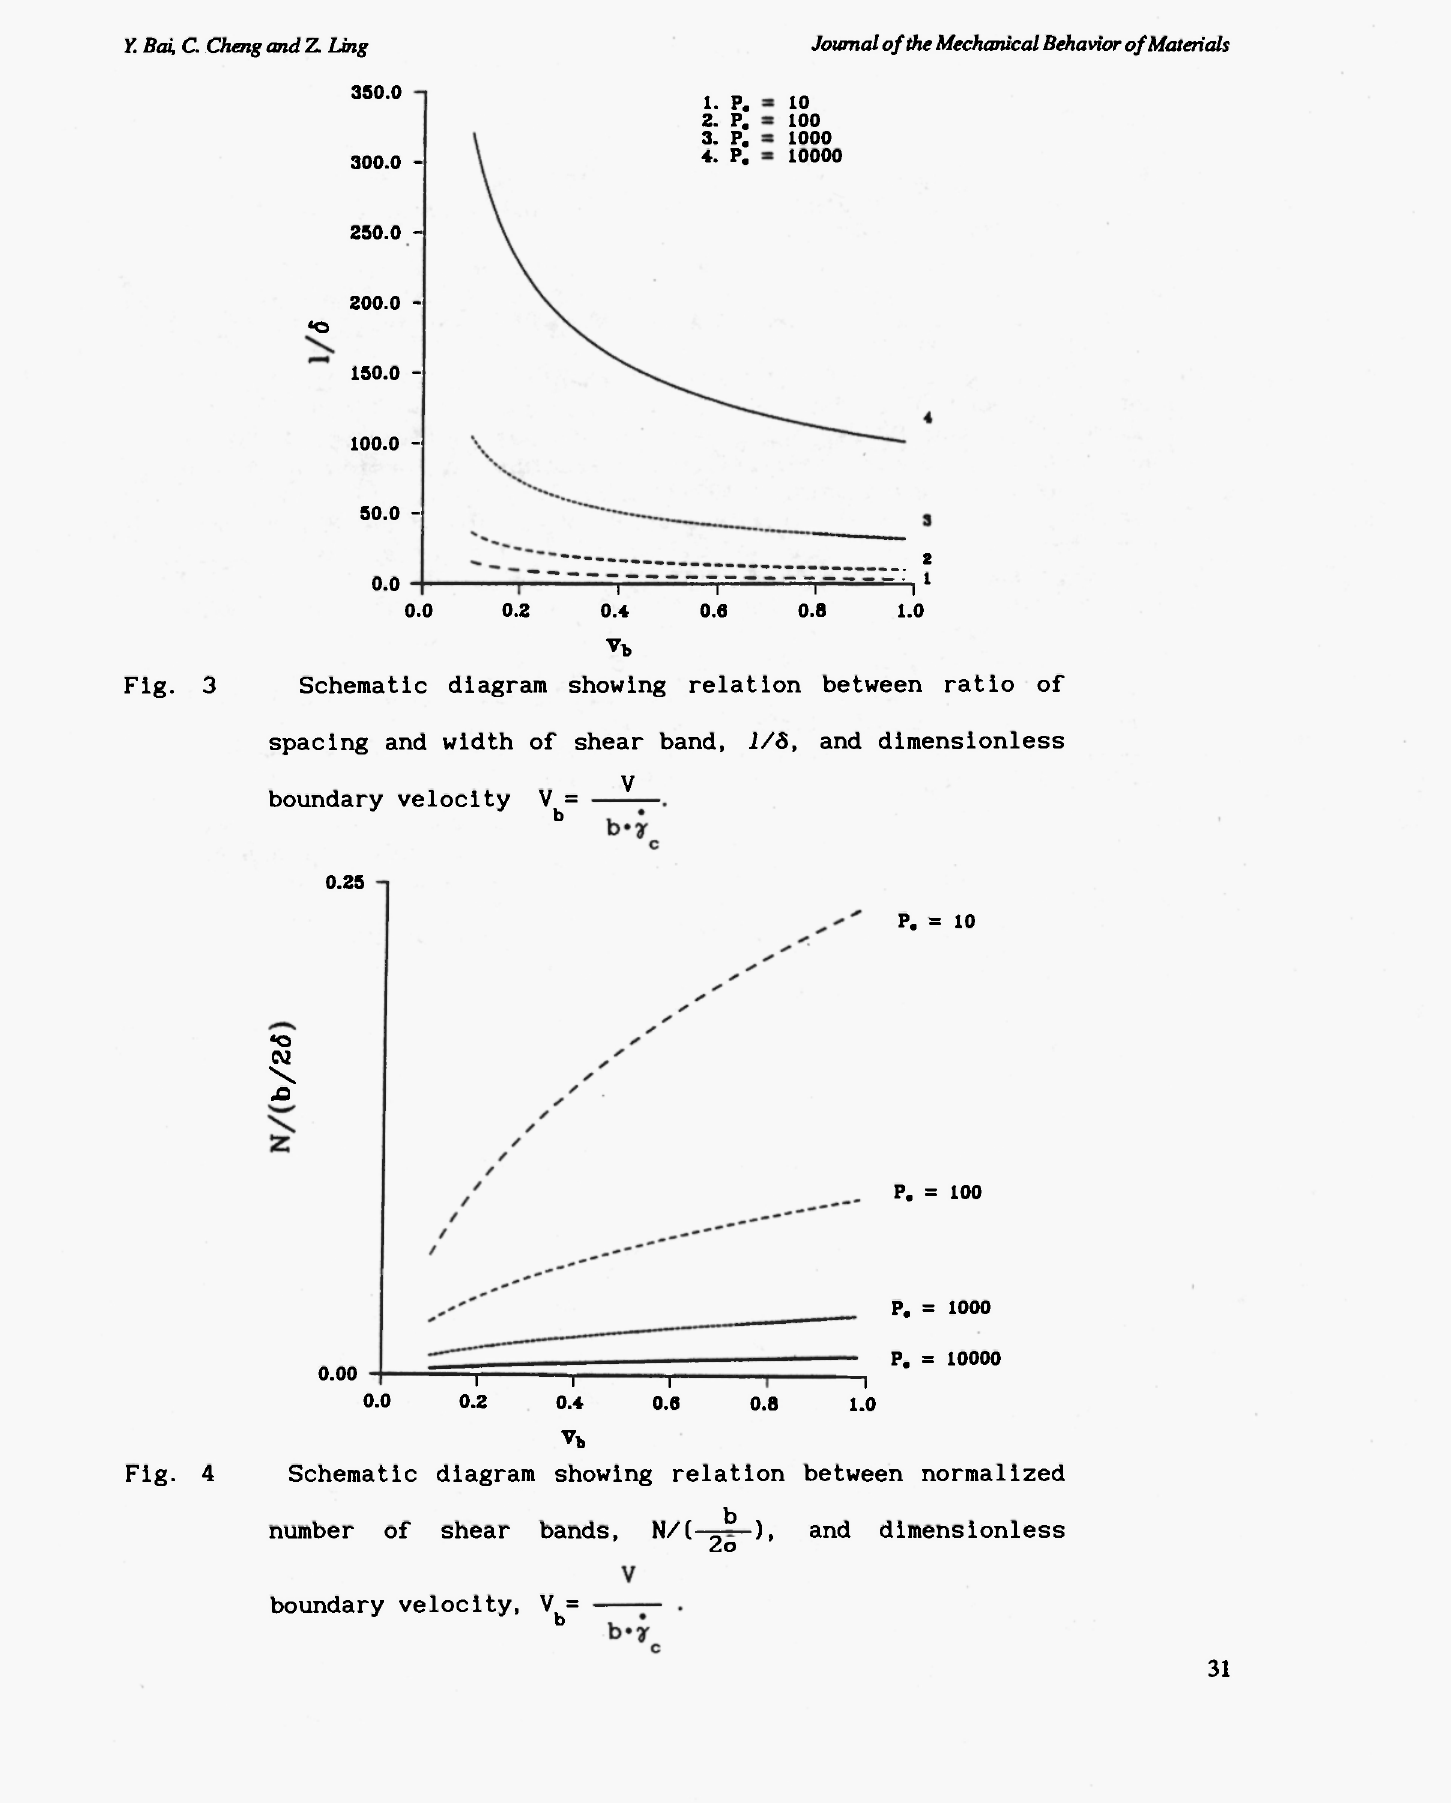
3 Schematic diagram showing relation between ratio of spacing and width of shear band, l / δ, and dimensionless V boundary velocity